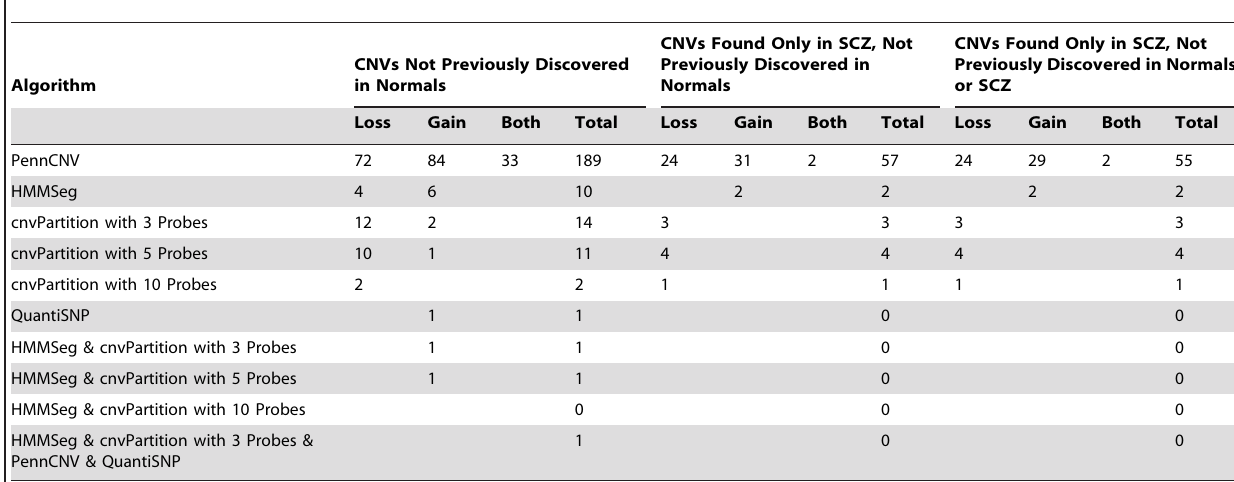
Table 5. ‘‘Newly discovered’’ CNVs detected by each algorithm based on 48 normal and 48 schizophrenia subjects, using the ‘‘any’’ overlap criterion.